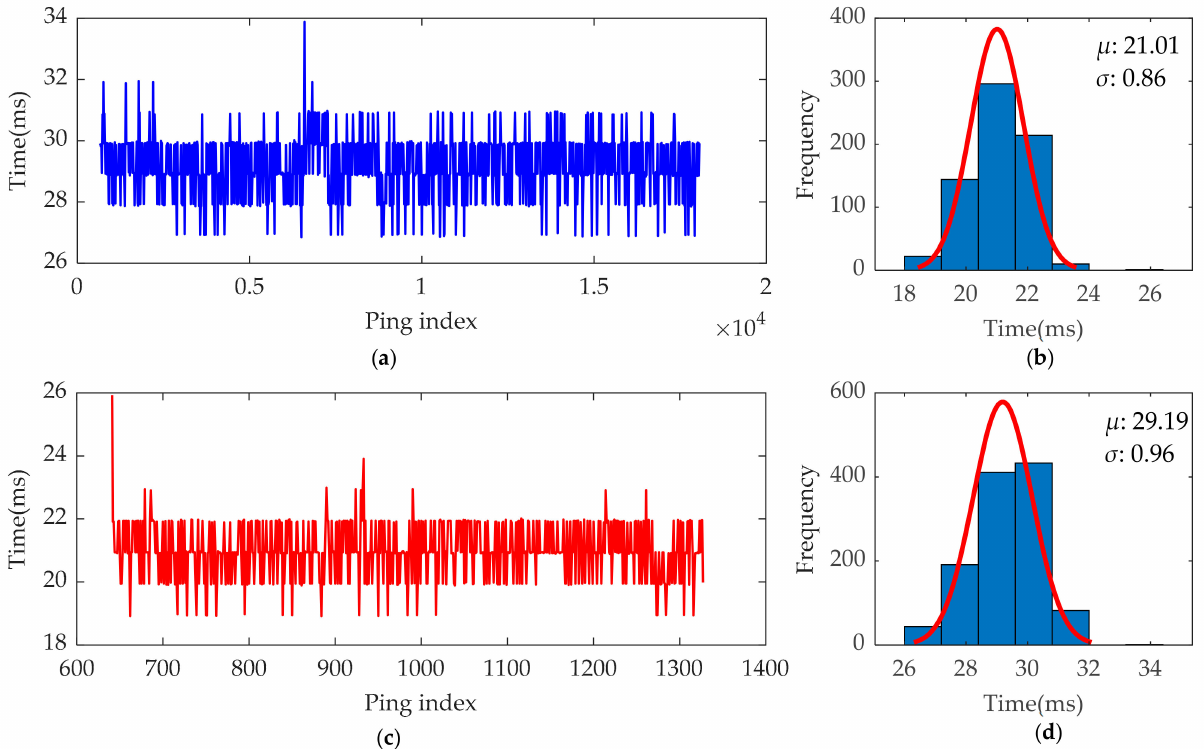
Figure 26. Statistical results of the time spent on pipeline detection for each ping. ( a ) Pipeline detection time spent on each ping of survey line 1; ( b ) pipeline detection time distribution for each ping of survey line 2; ( c ) pipeline detection time spent on each ping of survey line 2; ( d ) distribution of the time spent on each ping of survey line